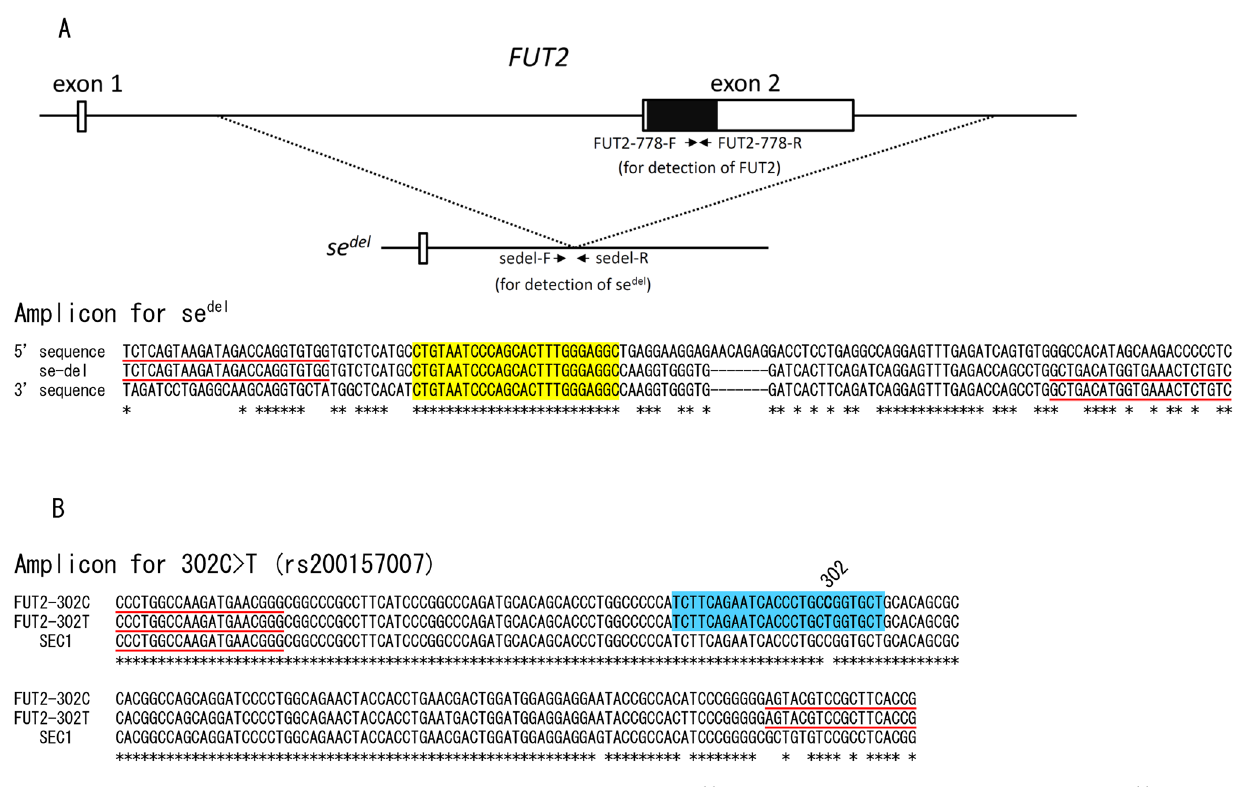
Figure 1. ( A upper) Gene structure of FUT2 and se del and relative position of the deleted region of se del . Two exons of FUT2 are indicated by white boxes, and the protein coding region in the second exon is indicated by a black box. Positions of PCR primers for duplex real-time PCR to amplify FUT2 (FUT2-778-F and -R) and se del (sedel-F and -R) are shown by black arrows. ( A lower) Alignment of DNA sequences of amplified regions of 127-bp encompassing the se del junction. DNA sequences of the 5 ′ breakpoint (5 ′ sequence), 3 ′ breakpoint (3 ′ sequence), and junction region of se del (se-del) within Alu elements are indicated. Yellow box indicates 25-bp homologous sequence breakpoints at the 5 ′ and 3 ′ ends of the deletion. PCR primer sequences (sedel-F and -R) are underlined in red. An asterisk shows an identical nucleotide among the three sequences. ( B ) Alignment of DNA sequences of amplified region of 195-bp encompassing rs200157007 (FUT2-302C: allele of C, FUT2- 302T: allele of T at 302C > T), and corresponding regions of SEC1 are indicated. Blue box indicates the Eprobe sequence. The position of rs200157007 is also indicated as 302. PCR primer sequences are underlined in red. An asterisk shows an identical nucleotide among three